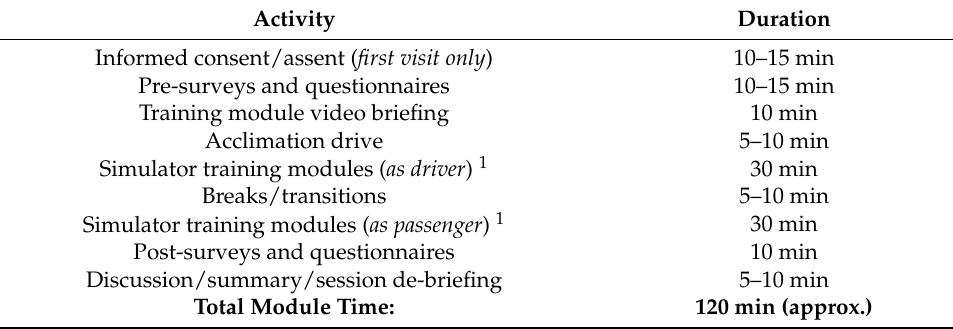
Table 2. Experimental Protocol for Each Instructional